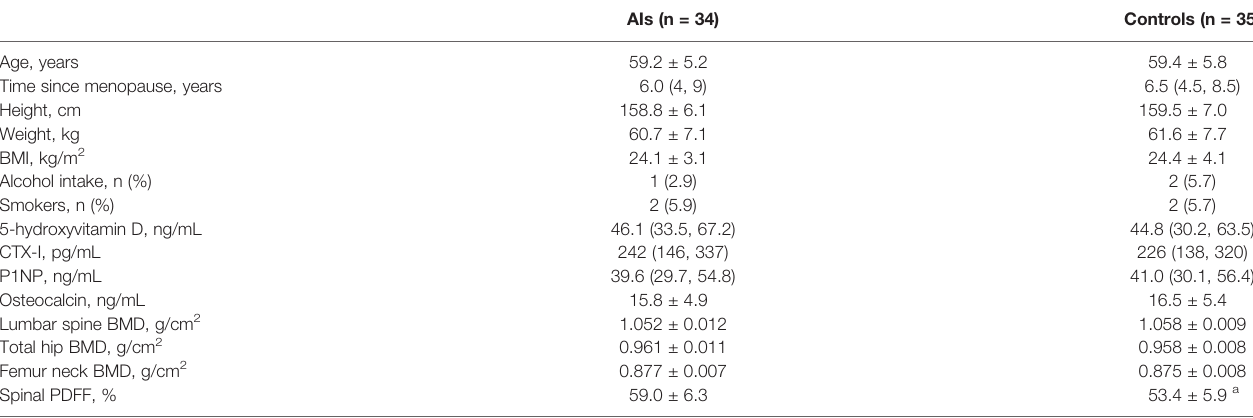
TABLE 1 | Baseline characteristics of the study